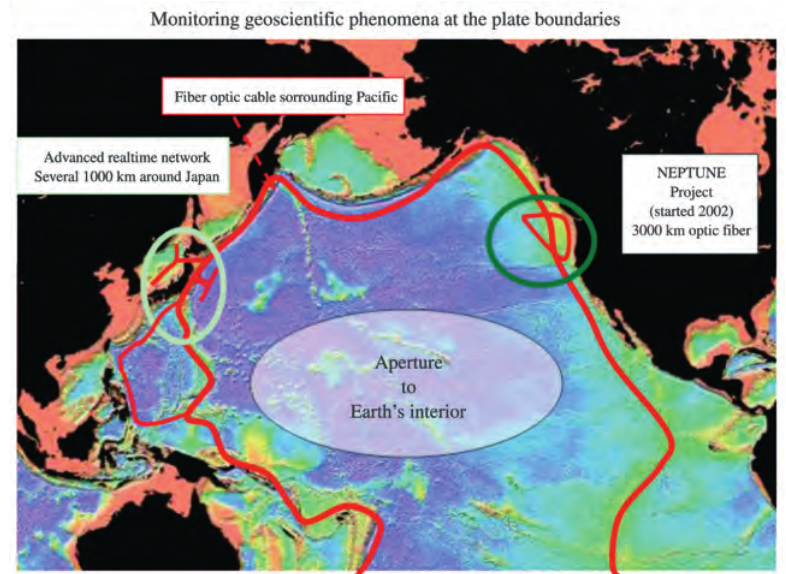
Fig. 10. Global scale observation network of Pacific